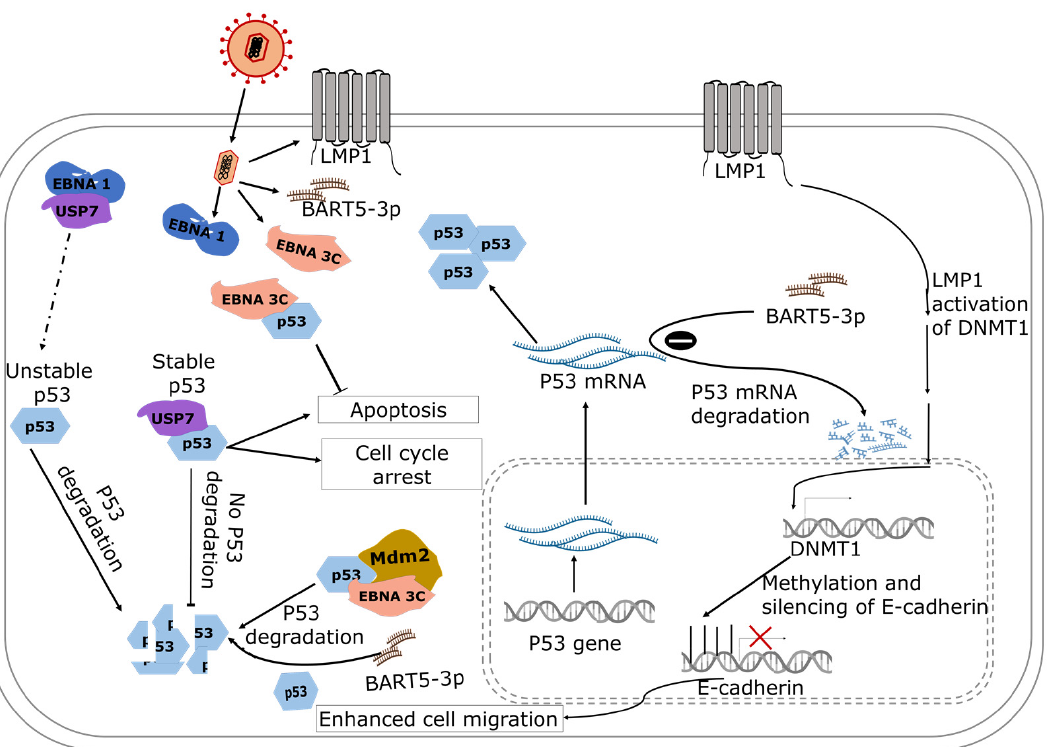
Figure 2. A model showing the role of EBV gene products in the regulation of nasopharyngeal carcinoma. EBNA-1 interacts with USP7 and indirectly reduces the stability of p53, and the unstable p53 is degraded. EBNA-3 binds with p53 to inhibit apoptosis and favors cell proliferation. In addition, BART5-3p is involved in the degradation of p53 mRNA and downregulates the expression of p53. The broken arrow represents the indirect activity of EBNA1 resulting in unstable p53. The solid arrows show the direction of the associated pathways.